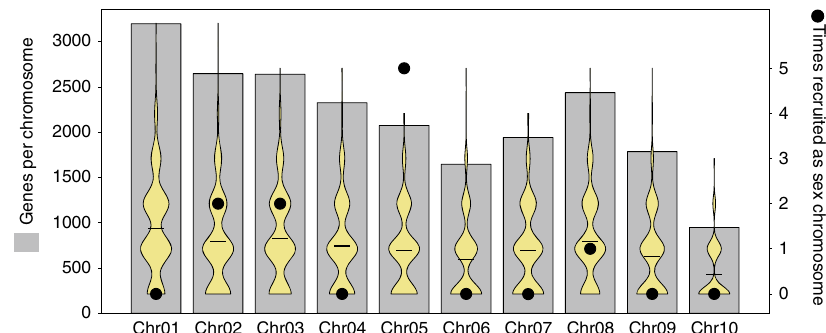
Fig. 2 Non-random recruitment of chromosomes for sex determination. Grey bars represent the number of genes per X. tropicalis chromosome. Violin plots show the expected number of times each chromosome would be recruited if genes were recruited for sex determination at random (1000 replicates). Black dots represent the number of times each chromosome was observed as recruited from our